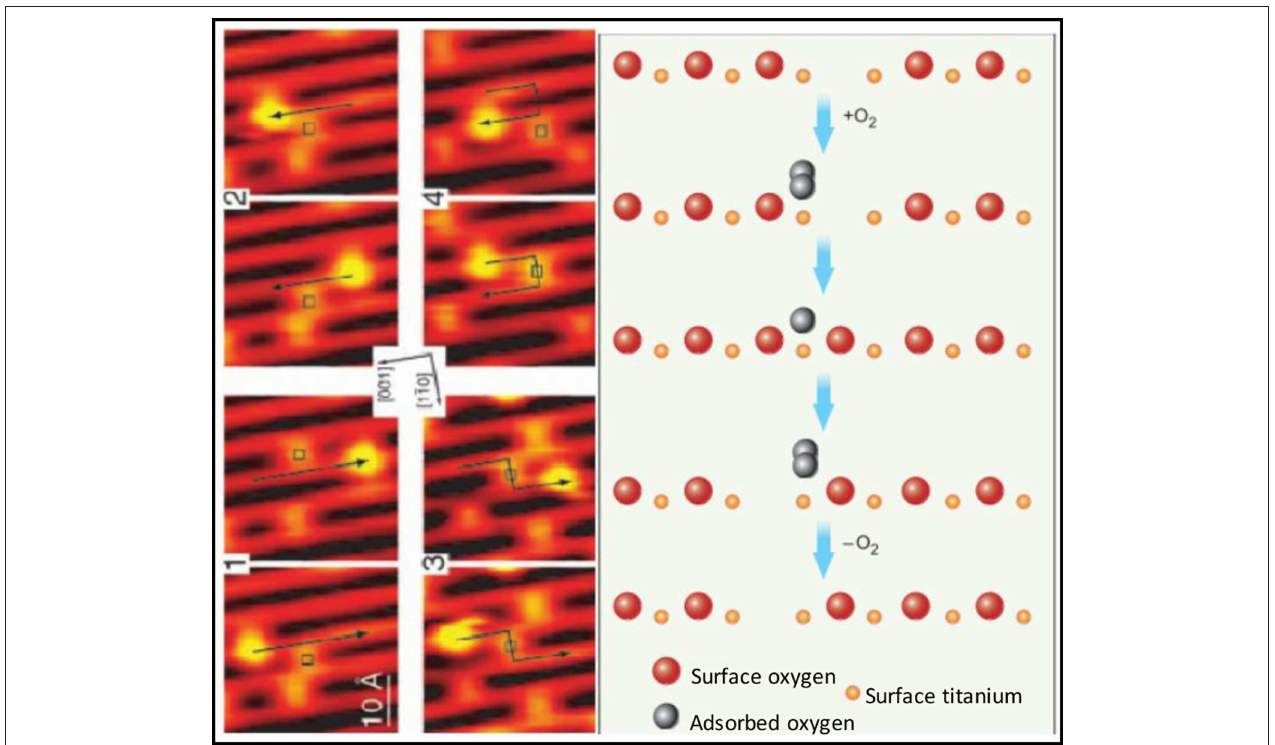
FIGURE 3 | Mobility of oxygen vacancies on the surface of TiO 2 . STM images (left) and schematic diagram (right) (adapted from Campbell, 2003; Schaub et al., 2003). In the left images, each number symbolizes the microscopy of a region different. Each number shows two microscopy images, the first before the movement and the second after the